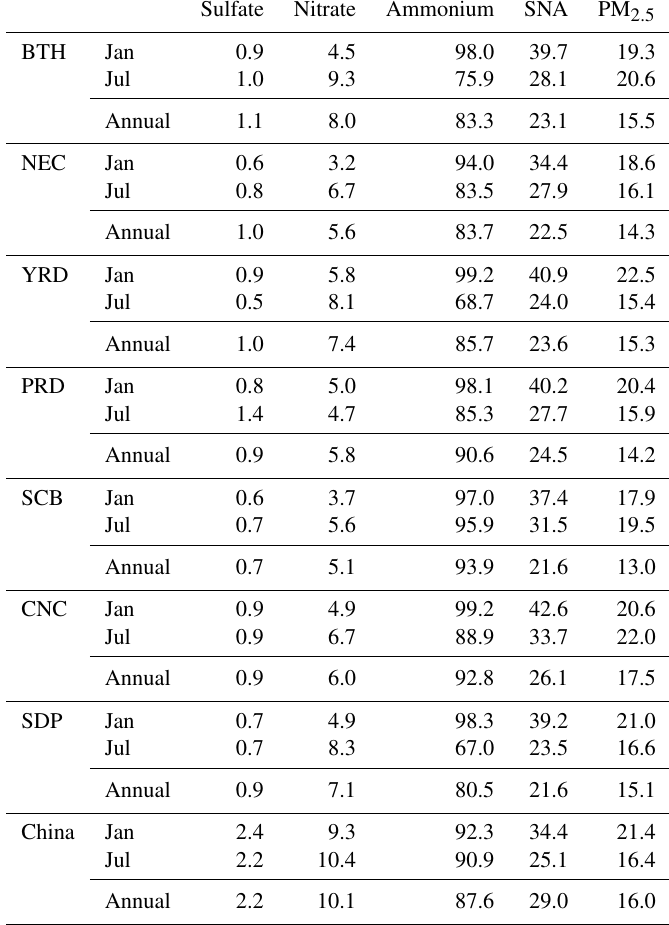
Table 4. The regional percent (%) of T agr NH 3 contribution to sulfate, nitrate, ammonium, and SNA mass concentration.